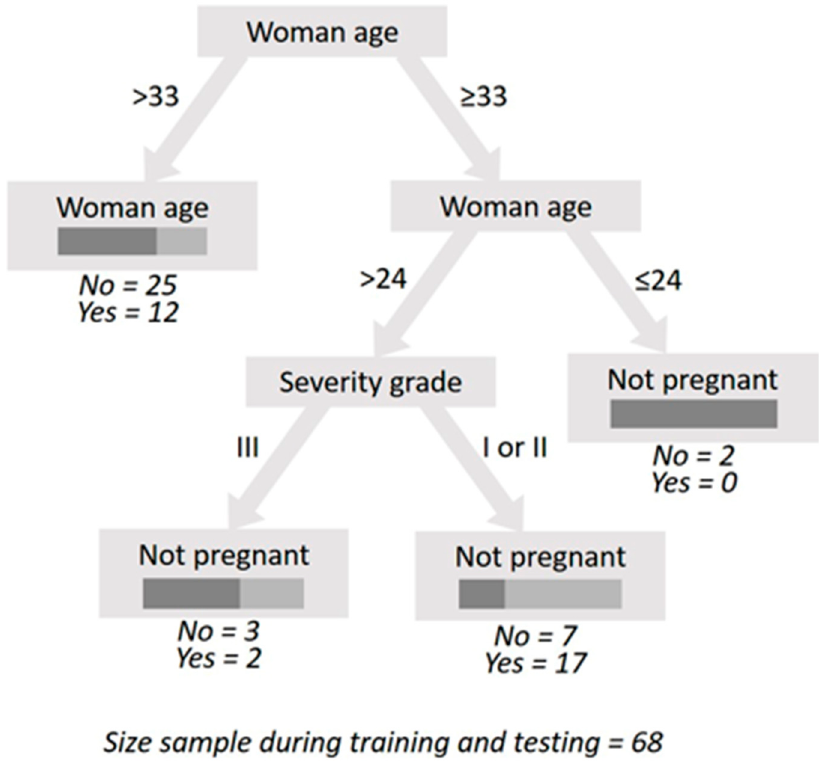
Figure 3. Decision tree for the prediction of the varicocele embolization success. The test design entailed the sub-sampling of 85 patients: 48 patients for training; 20 patients for testing, and 17 patients for validating the decision tree. This computed decision tree was obtained with the following parameter values after exhaustive training/testing: sampling type during training/testing = linear; decision tree splitting criterion = accuracy; decision tree pruning = true; decision tree minimal size for split = 4; decision tree minimal gain = 0.1; decision tree minimal leaf size = 2; and decision tree maximal depth = 20. During its training/testing, the decision tree computed the following performance measures: accuracy = 80.00%; precision = 85.71%; recall = 66.67%; F-measure = 75.00%; and AUC = 0.717. During its validation, the performance measures were: accuracy = 70.59%; precision = 66.67%; recall = 75.00%; F-measure = 70.59%; and AUC = 0.750 with the confusion matrix shown in Table 2. Decision tree´s confusion matrix.